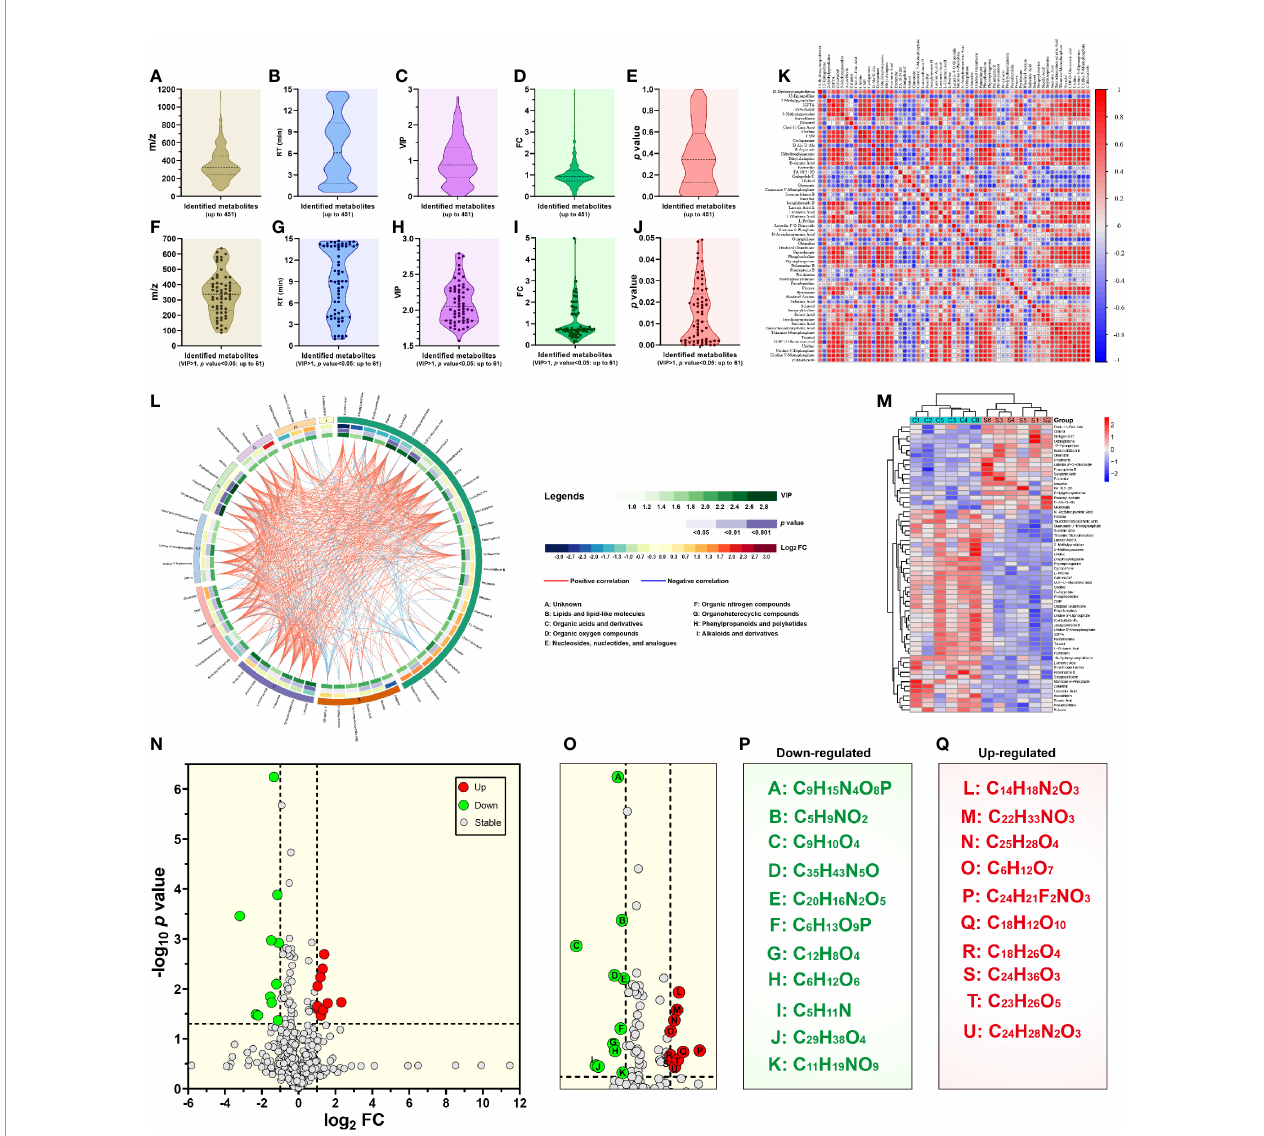
FIGURE 3 | Metabolomic pro fi ling and differential metabolite analysis. Data distributions of mass-to-charge ratio (m/z) (A) , retention time (RT) (B) , variable importance for the projection (VIP) (C) , fold change (FC) (D) and p value (E) for all 451 identi fi ed metabolites. Data distributions of m/z (F) , RT (G) , VIP (H) , FC (I) and p value (J) for 61 signi fi cantly differential metabolites. Matrix heatmap based on calculation of Pearson ’ s correlation coef fi cients for signi fi cantly differential metabolites (K) . − 1 < Pearson ’ s correlation coef fi cient (R) < 1. Chord diagram based on calculation of Pearson ’ s correlation coef fi cients for signi fi cantly differential metabolites (L) . 0.7 < absolute value of Pearson ’ s correlation coef fi cient (R). Heatmap showing hierarchical clustering of signi fi cantly differential metabolites (M) . Volcano plot revealing p value versus FC for all 451 identi fi ed metabolites (N) . The threshold values are set as VIP > 1.0, FC > 2.0 or FC < 0.5, and p value < 0.05. Locally enlarged volcano plot that highlights eleven downregulated (letter A to K in green circles) and ten upregulated (letter L to U in red circles) metabolites (O) . Formulas of eleven downregulated metabolites (P) . Eleven generic names of metabolites, corresponding to their formulas, are listed in Supplementary File 1 . There are two